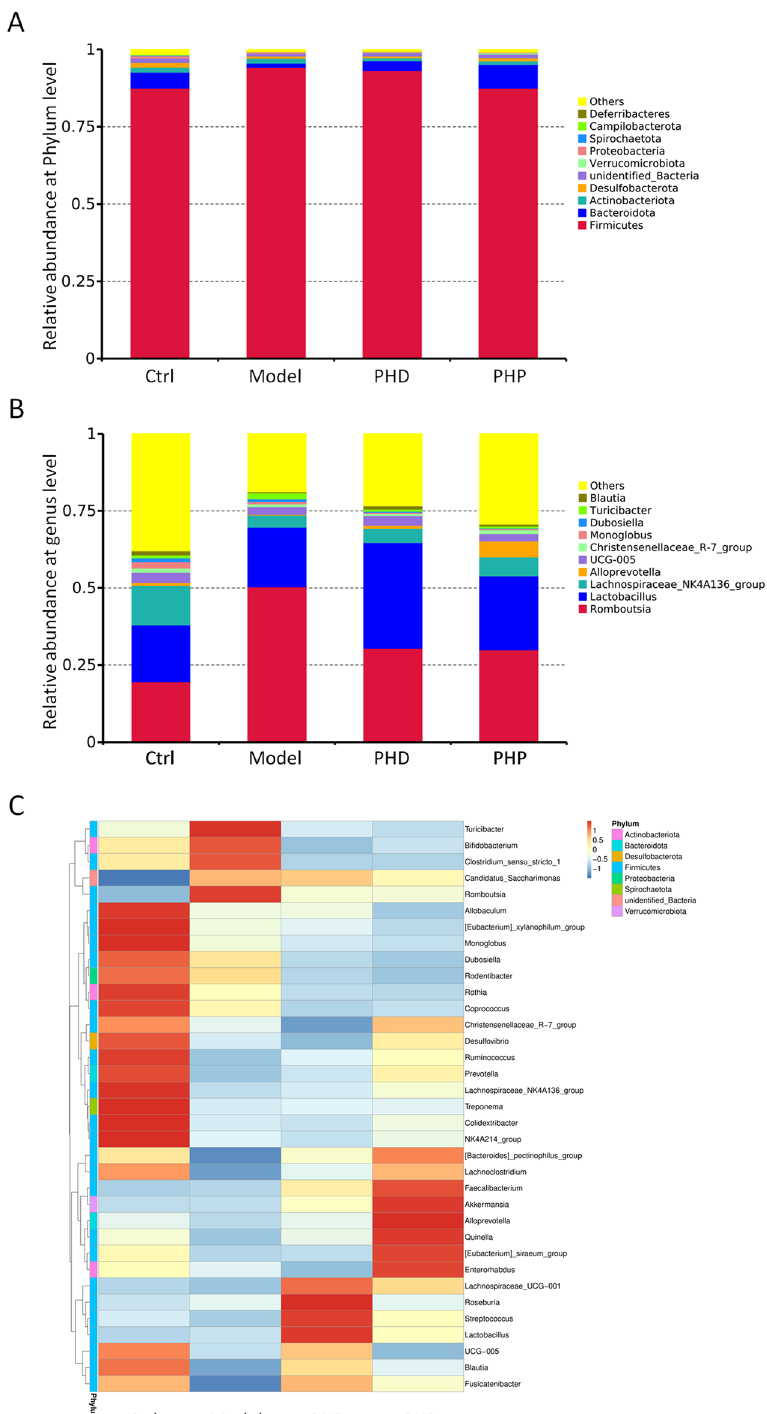
Figure 7. Effect of PHD and PHP on the composition and relative abundance of gut microbiota in the rats with spleen deficiency-induced diarrhea. ( A ) Relative abundance of gut microbiota at the level of phylum; ( B ) Relative abundance of gut microbiota at the level of genus; ( C ) Cluster heatmap of relative species abundance at genus